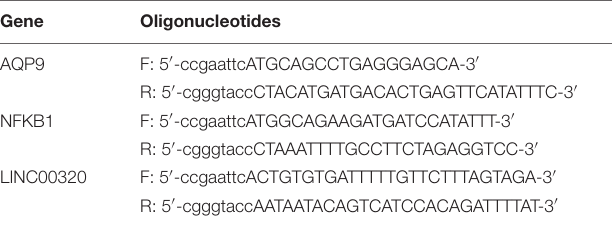
TABLE 2 | Oligonucleotides for cell